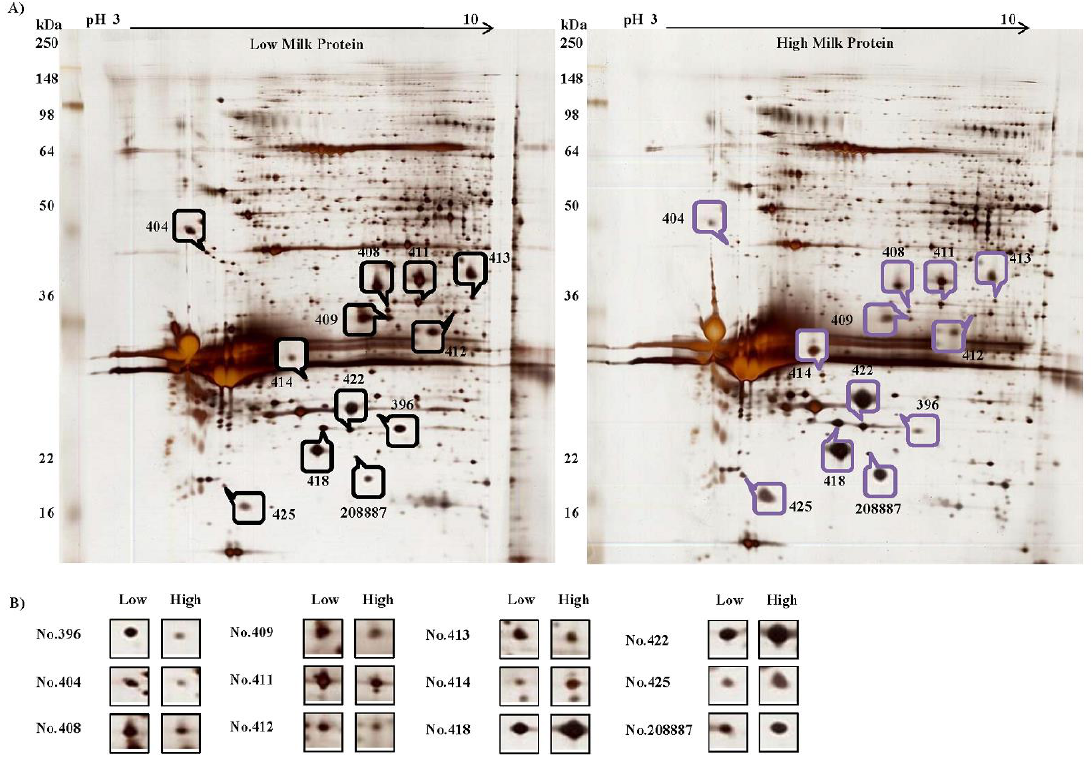
Figure 2. Representative two-dimensional gel electrophoresis (2-DE) images of isolated milk epithelial cells (MECs) ( A ) and differently expressed proteins ( B ).